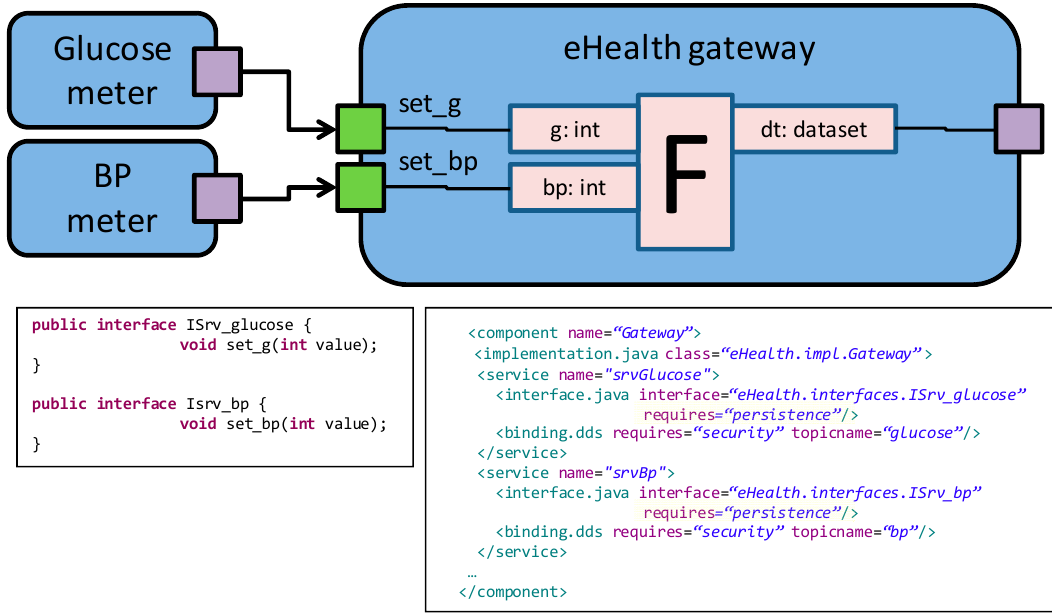
Figure 11. Configurable data Figure 11 . Configurable data persistence.